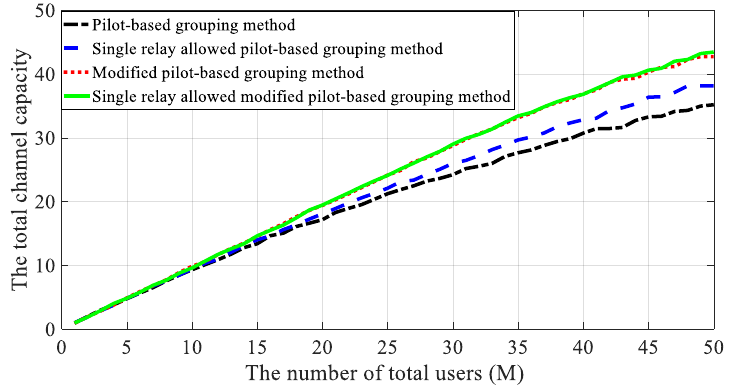
Figure 6. The comparison of the total system channel capacity of the pilot-based, single relay al- lowed pilot-based, modified pilot-based, and single relay-allowed modified pilot-based grouping methods.